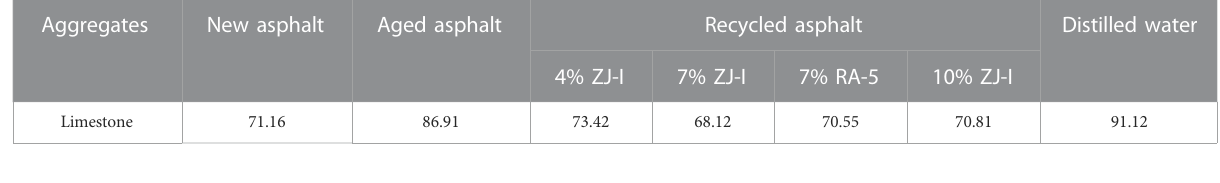
TABLE 15 Contact angle of aggregate with asphalt and water. Aggregates